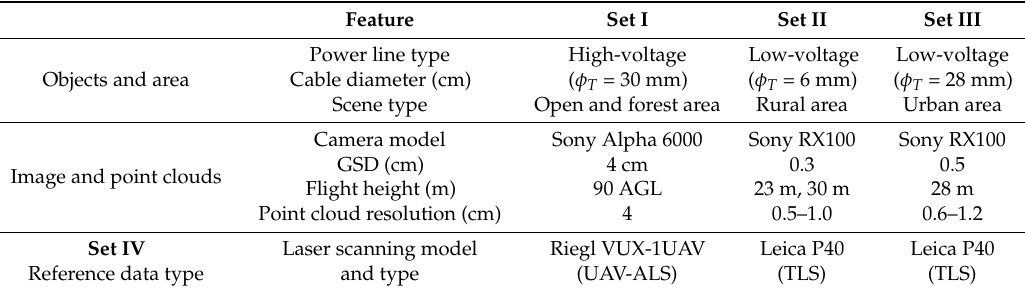
Table 1. Overview of the test data